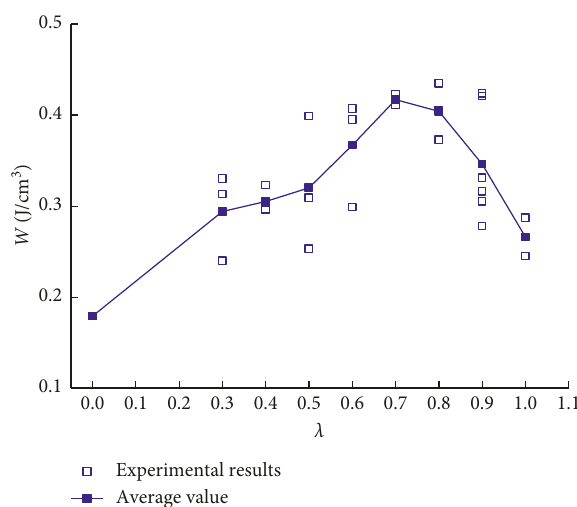
Figure 13: Dissipated energy density of artificial frozen silty clay with different axial compressive stress ratios under coupled